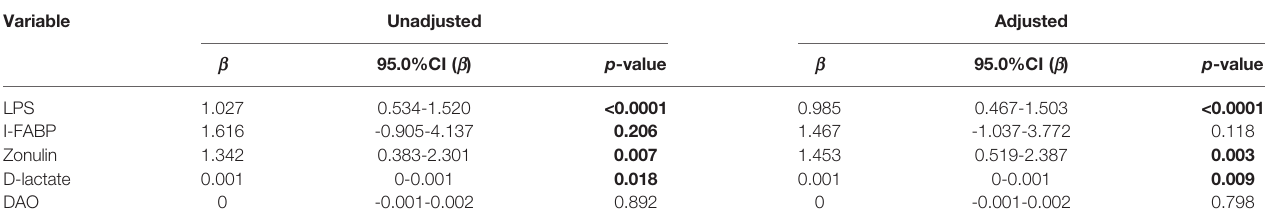
The values of TRAb, LPS, I-FABP and zonulin were Log-transformed. Adjusted for age, gender, BMI. Statistically p values are